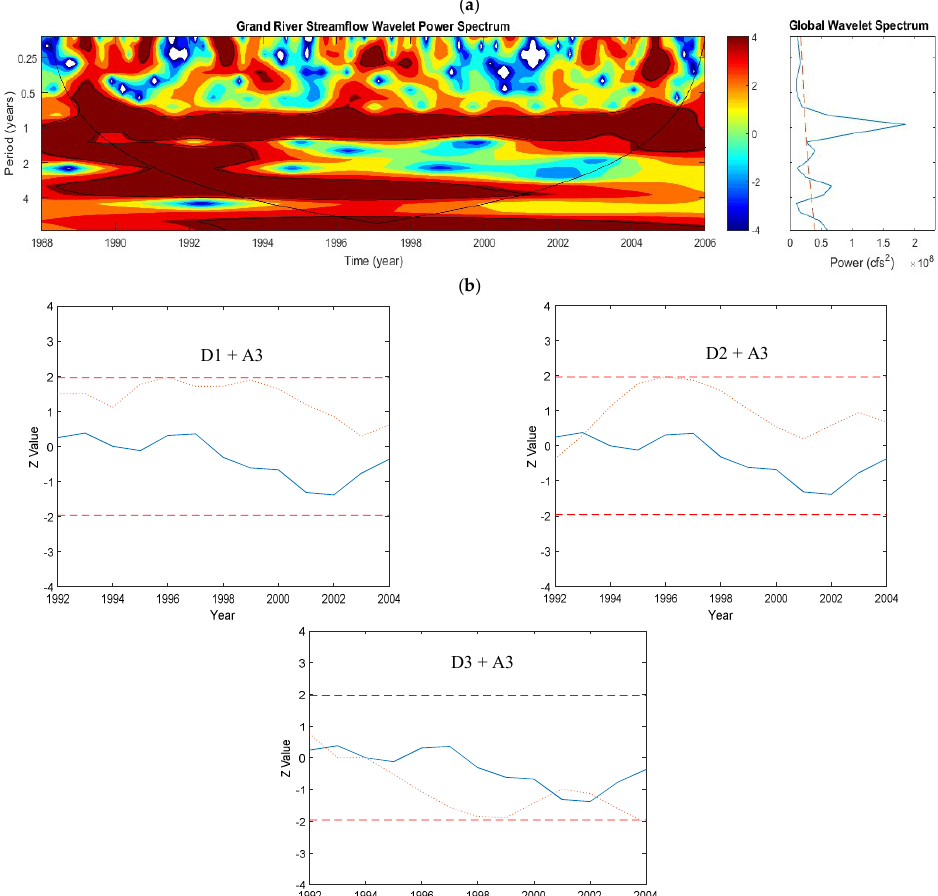
Figure 18. Grand River: ( a ) Continuous wavelet transform of daily streamflow. ( b ) Plots of the sequential Mann–Kendall analyses on the Details (with added Approximation component) of the annual streamflow data. The top and bottom dashed lines are ±1.96, which are the confidence limits of the MK test using α = 5%. The solid and dotted lines show the sequential MK values for the original data and the Detail components, respectively. For this streamflow data, the D1 (2 years) and D2 (4 years) components were the most dominant periodicity for this trend.